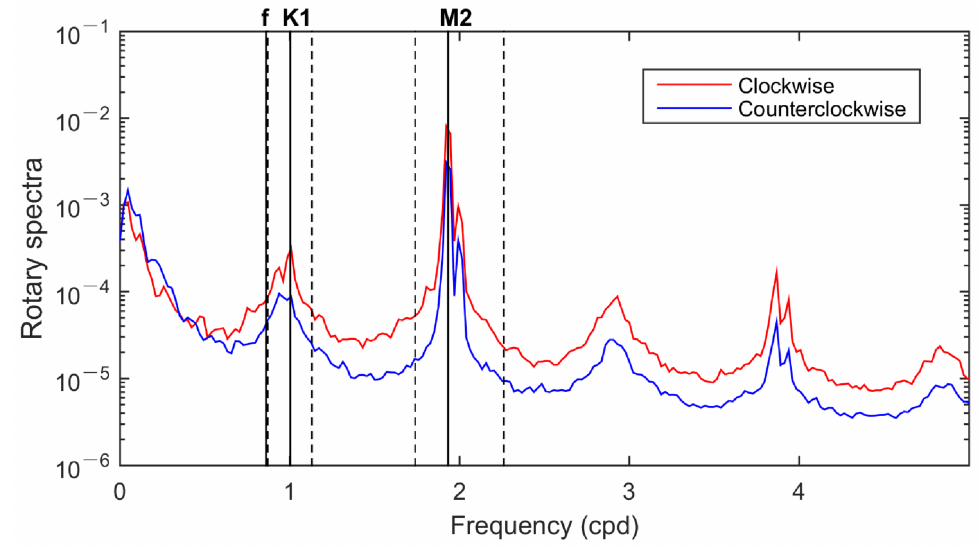
Figure 2. Depth-averaged rotary spectra (unit: m 2 s − 2 ) for clockwise and counterclockwise com- ponents of raw velocity at the mooring station. The dashed lines represent the frequency bands of 0.87–1.13 and 1.74–2.26 cpd.